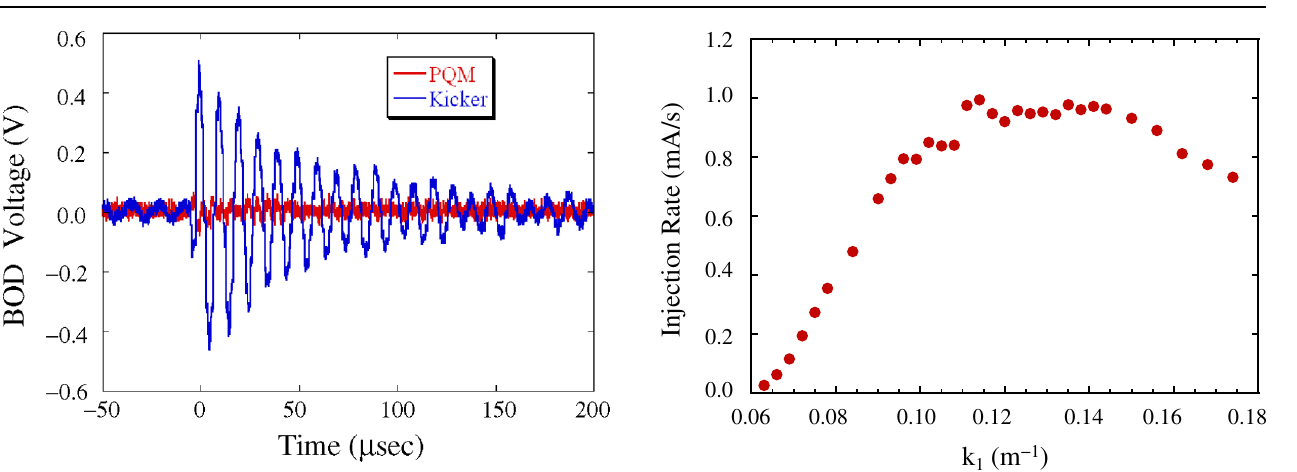
FIG. 22. (Color) Injection rates are shown as a function of the . k ranges from 0.06 to 0 : 18 m (cid:5) 1 . The rates physical strength k 1 1 are calculated from straightline fits over 20 s.